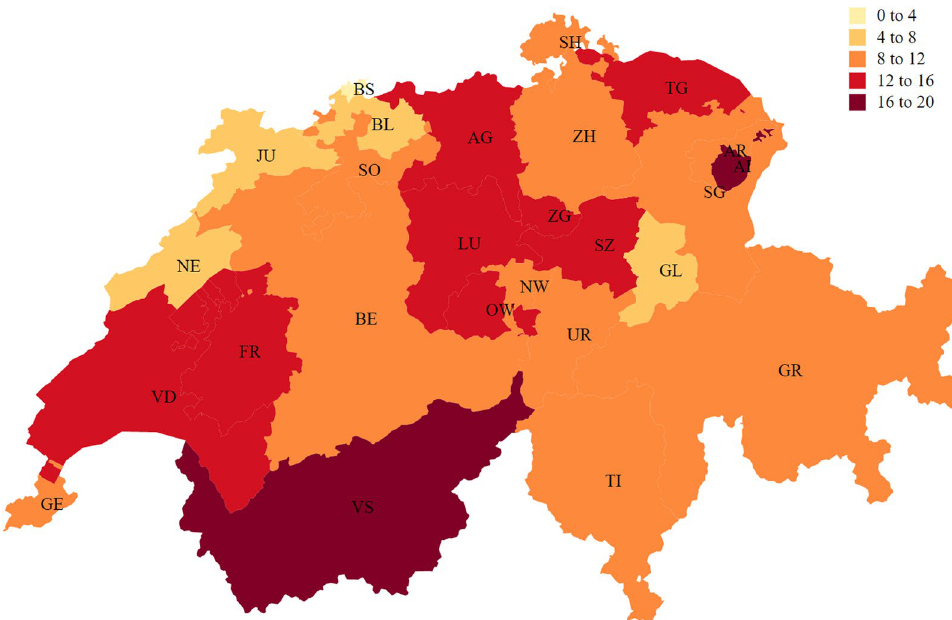
Fig. 8 Growth in housing supply from 2009 to 2016 in % by canton. Notes: Mapped variable: ( Q T i ,2016 − Q T i ,2009 )/ Q T i ,2009 · 100 . The range (x to y) includes the lower number (x) and excludes the upper number (y). Source: Own calculations based on data from Federal Statistical Office